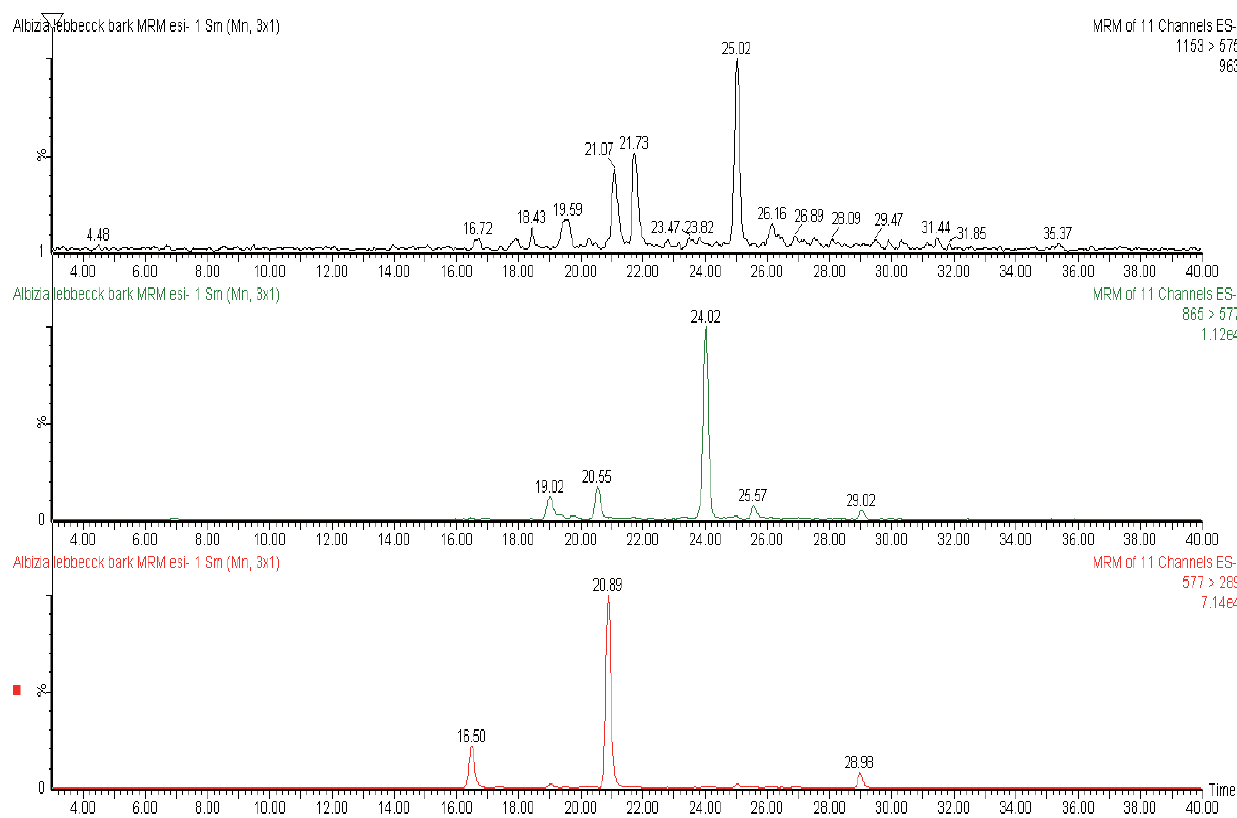
Fig. 3: MRM chromatograms of B-type procyanidins. In detail dimers identified through the interflavanic bond cleavage (577>289), as well as for trimers (865>577) and tetramers (1153>575). In the tetramers it is possible to note the quinone dimers formation (m/z 575).